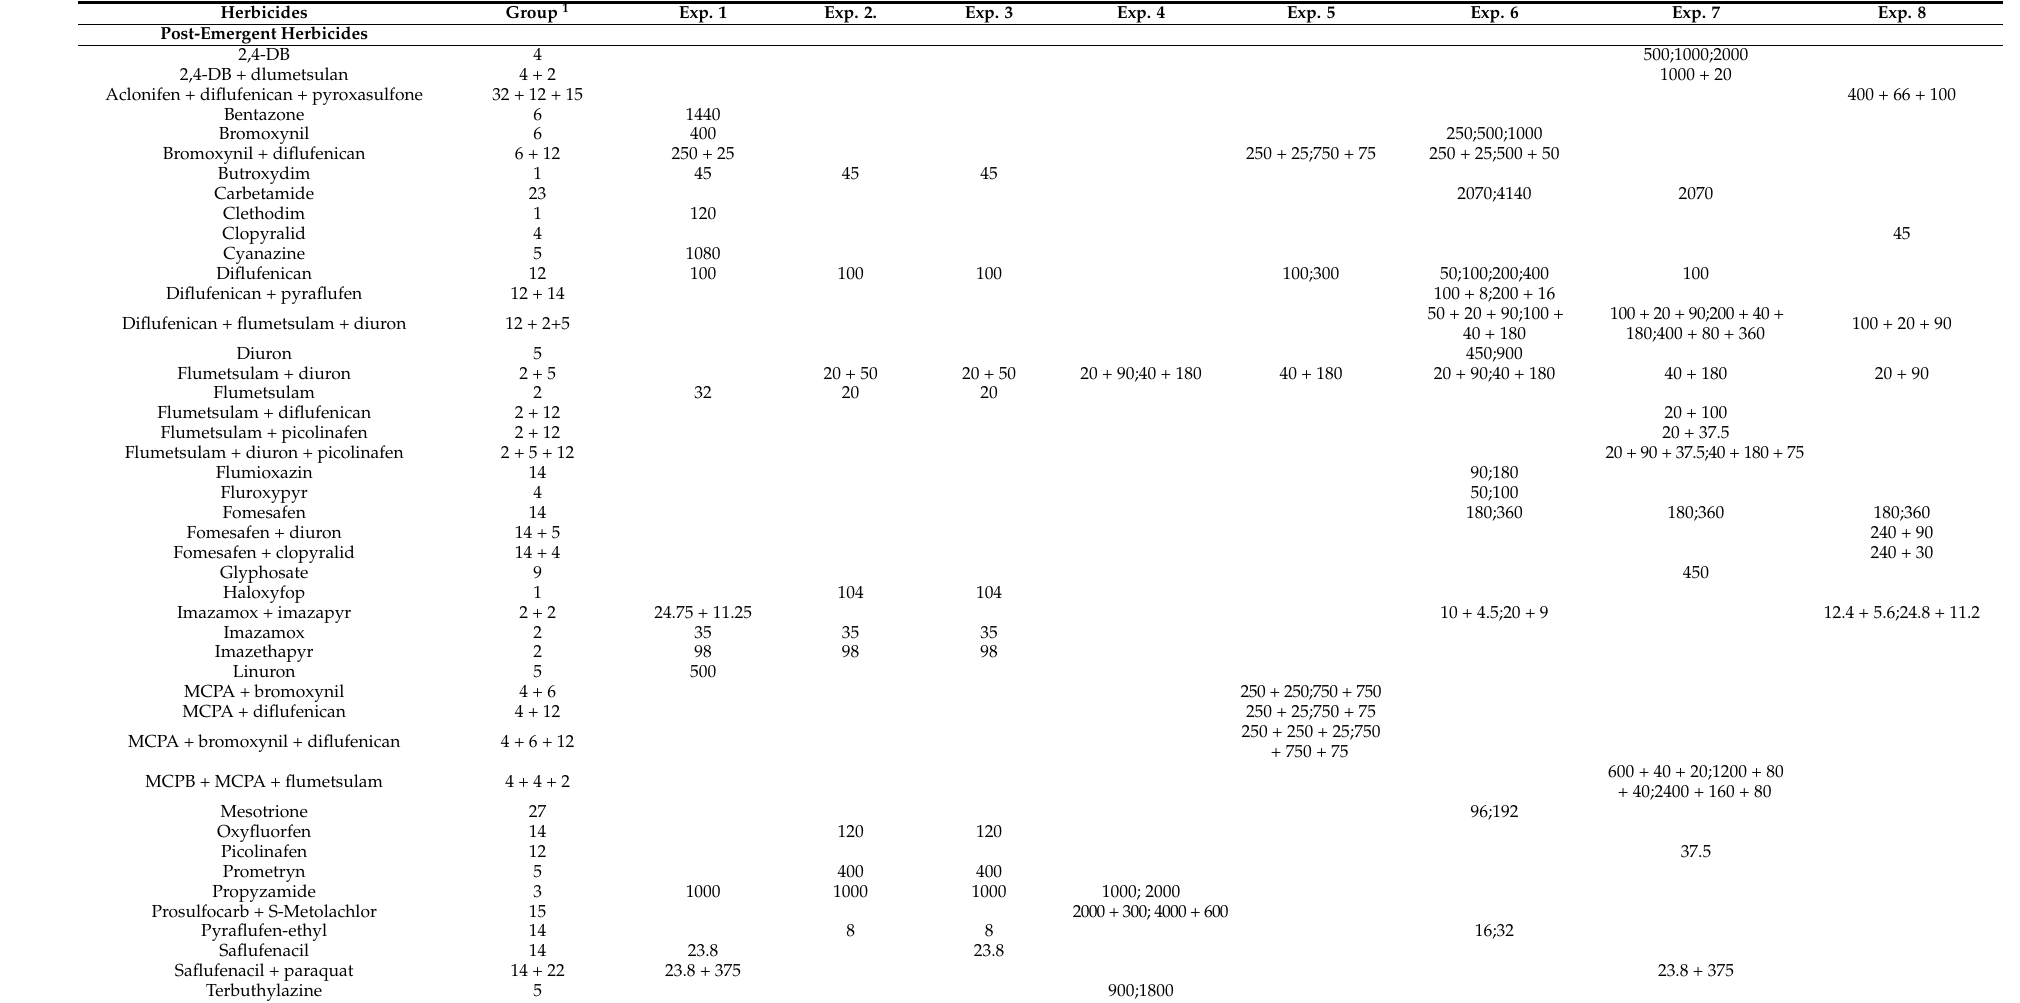
Table 3. Rates of active ingredient (a.i.) g/ha used in the eight experiments with post-emergent